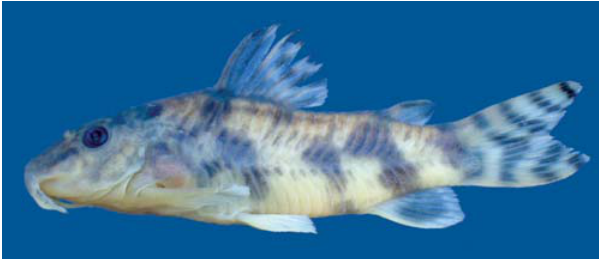
Fig. 2. Scleromystax salmacis , paratype, MCP 29299, male, 37.2 mm SL, arroio Molha Coco, Praia Grande, Santa Catarina,